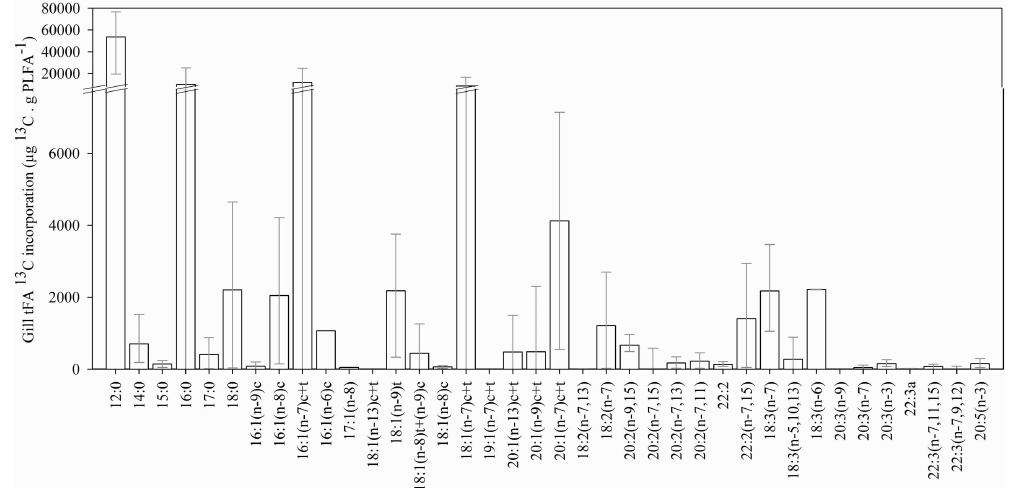
Fig. 3. Bathymodiolus azoricus gill tissue tFA ( n = 3, average ± min-max) 13 C incorporation per total PLFA content after a 20 day supply of dissolved 13 C-amino